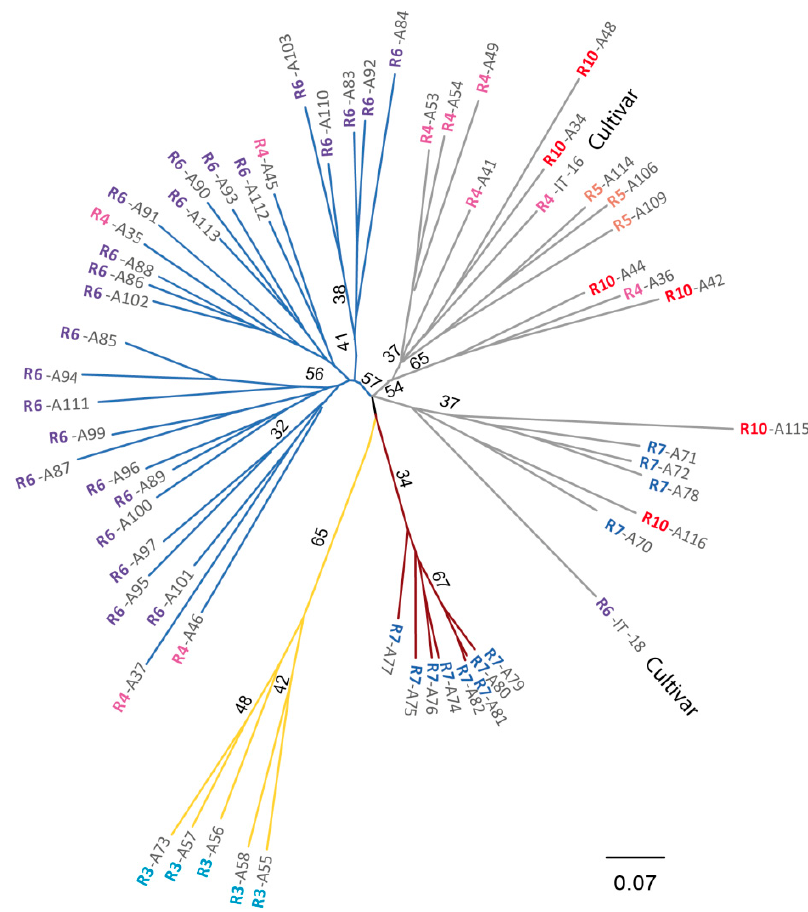
Figure 6. Unrooted neighbor-joining (NJ) tree of the studied Vigna unguiculata accessions, including the two cultivars, based on Nei’s Da genetic distance. Numbers associated with branches indicate bootstrap values (BS) based on 1000 replications. Only BS values above 30 are shown. The colors of branches indicate the four genetic groups found in STRUCTURE. AEZs are indicated in branch labels with different colors, following Figure 3.